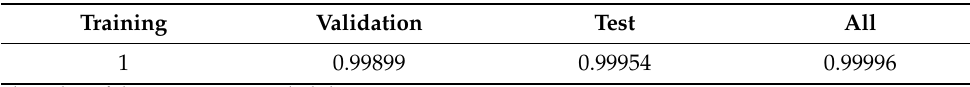
Table 7. Best validation performance and final state parameters. Table 8. The target